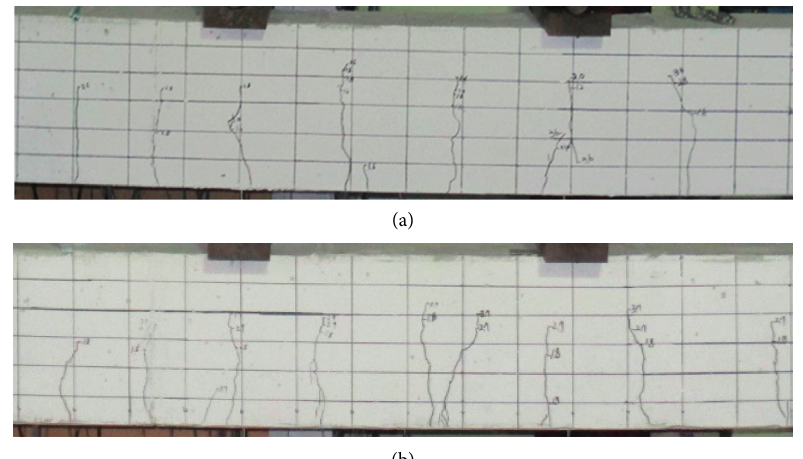
Figure 5: Typical crack patterns at the initial cracking stage ( P � P R050-S2. (d) Beam